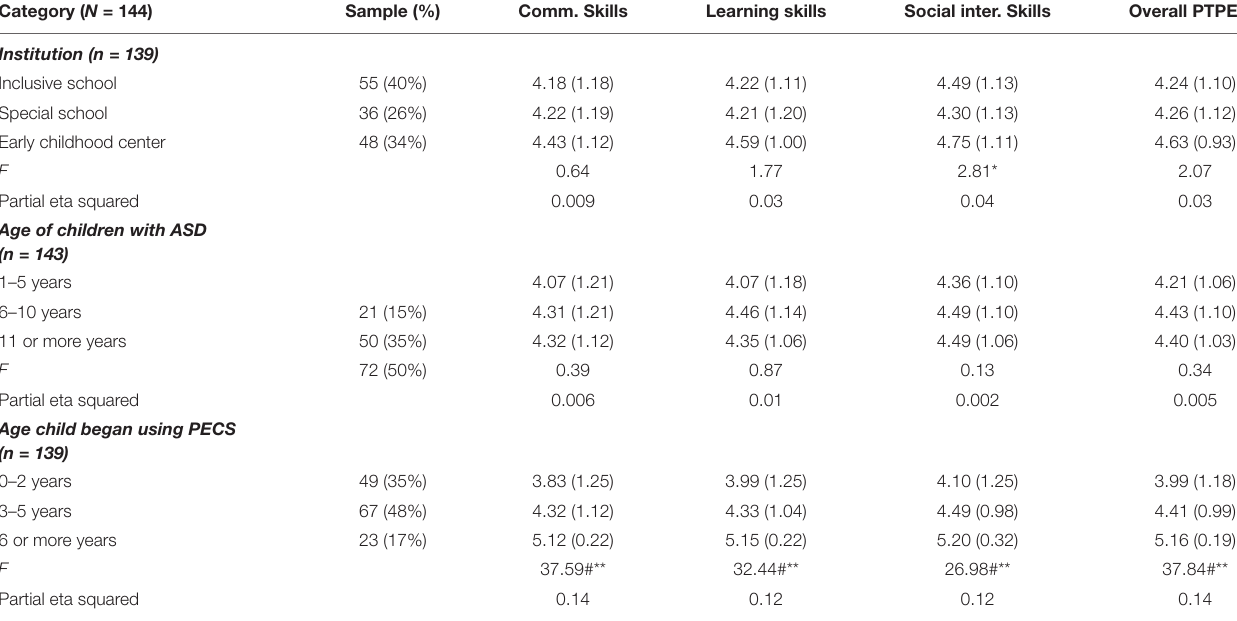
TABLE 2 | Summary of the association between three-level demographics and perceptions. Category ( N = 144) Sample (%) Comm. Skills Learning skills Social inter. Skills Overall